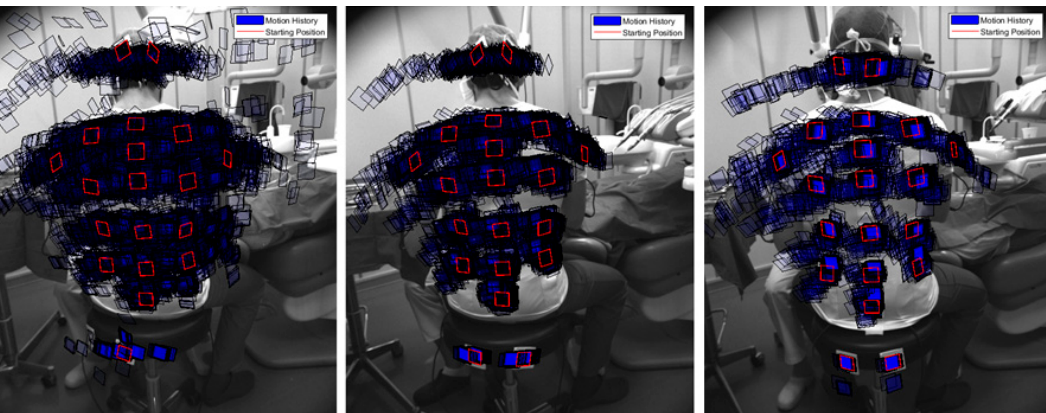
Figure 4. Superposition of the ArUco marker displacements detected during different surgical procedures starting from the reference position: ( Left ): An intervention based on the naked eye. ( Center ): An intervention using medical loupes. ( Right ): An intervention with the surgical microscope.